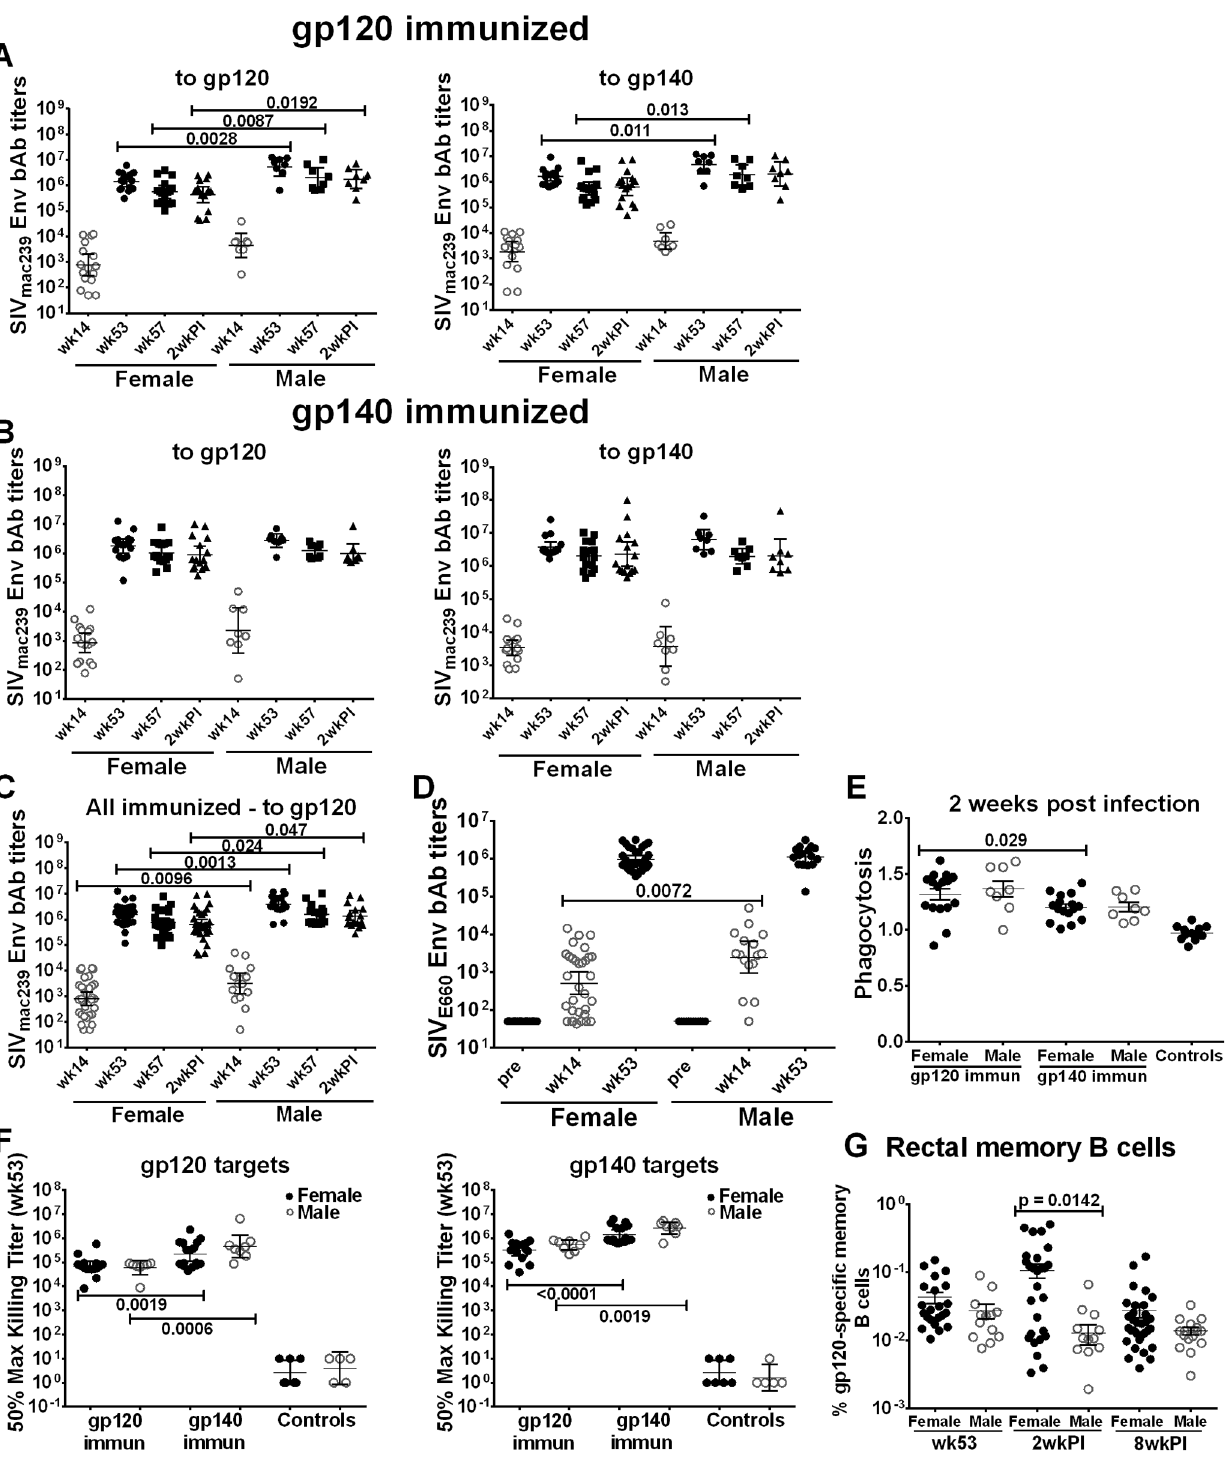
Fig 2. Comparison of immune responses between female and male macaques. Binding antibody titers to SIV mac239 gp120 and gp140 over the course of immunization and following infection in (A) gp120- and (B) gp140-immunized female and male macaques. (C) Binding antibody titers by sex of combined gp120- and gp140 immunization groups to SIV mac239 gp120 over the course of immunization and 2wkpi. (D) Binding antibody titers to SIV E660 gp120 over the course of immunization in females and males of combined gp120- and gp140-immunization groups. Pre-bleed samples were not tested but binding titers of control macaque samples at all time points were < 50. Titers are expressed as geometric means with 95% CL. (E) Serum phagocytic activity (phagocytosis